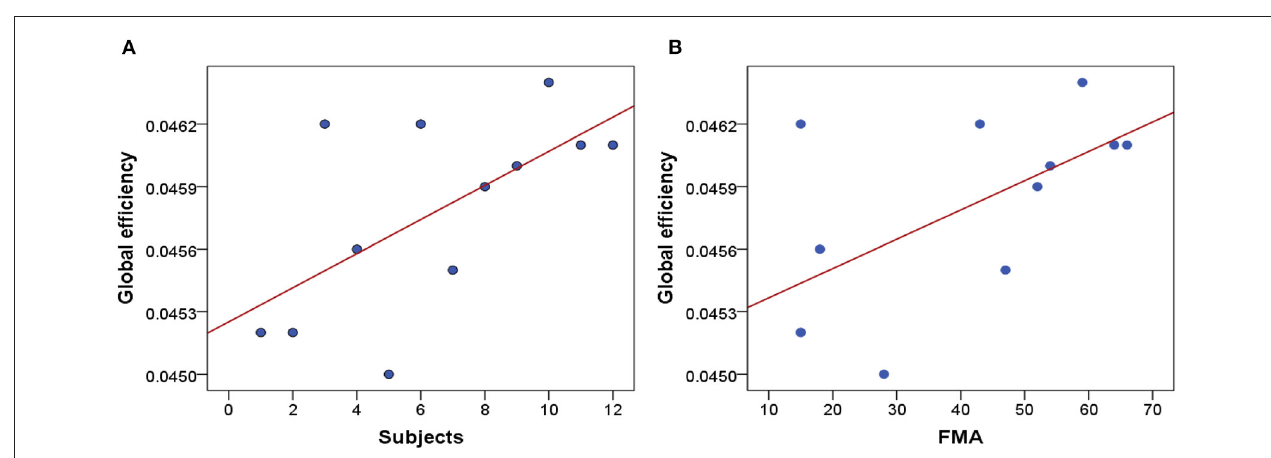
FIGURE 6 | Correlation analysis. (A) The average GE of 12 stroke patients. (B) Correlation between FMA scores and GE of 12 stroke patients.